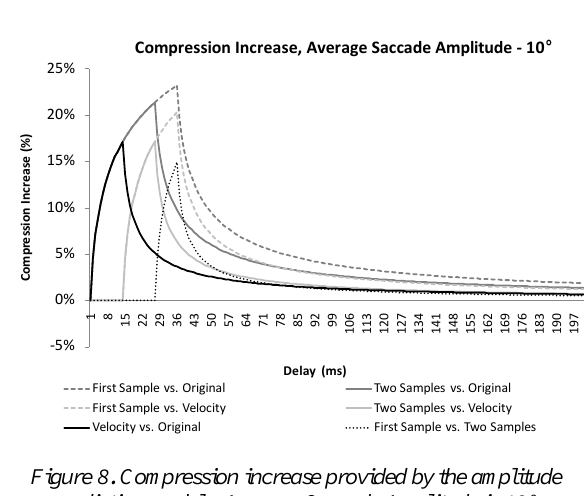
Figure 8. Compression increase provided by the amplitude prediction models. Average Saccade Amplitude is